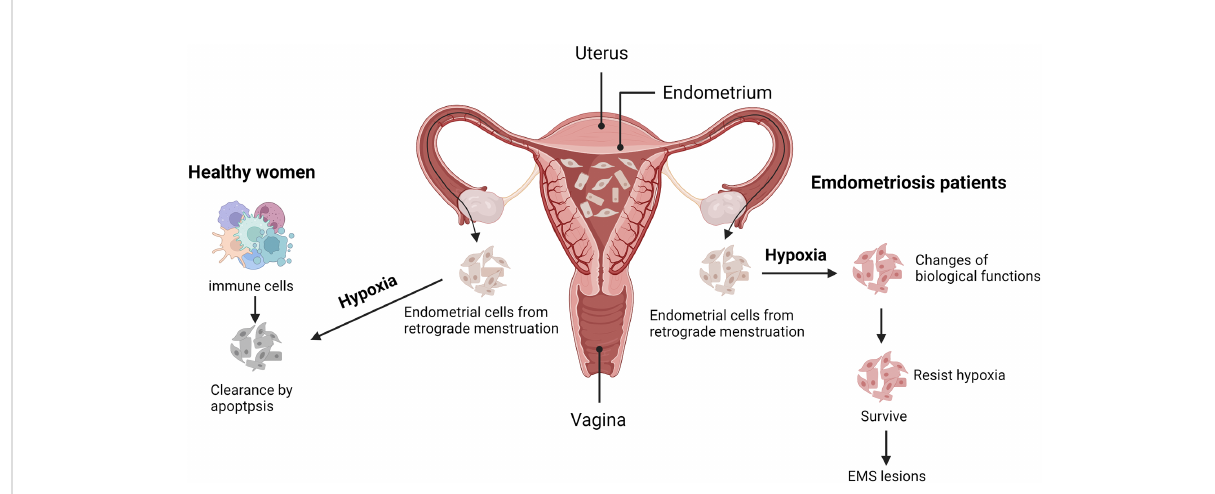
FIGURE 1 Possible adaptive mechanism for endometriosis under hypoxia. During menstruation, the exfoliated endometrium fragments fl ow into the pelvic cavity with retrograde menstruation. Under normal circumstances (as shown in the left part), the shedding endometrial cells will face acute hypoxic stress, activating apoptotic signals and being cleared by the immune cells. Conversely, those endometrial cells of endometriosis (EMS) patients (as shown in the right part), possess with altered biological functions, may resist hypoxia or apoptosis and fi nally develop into EMS lesions. Created with